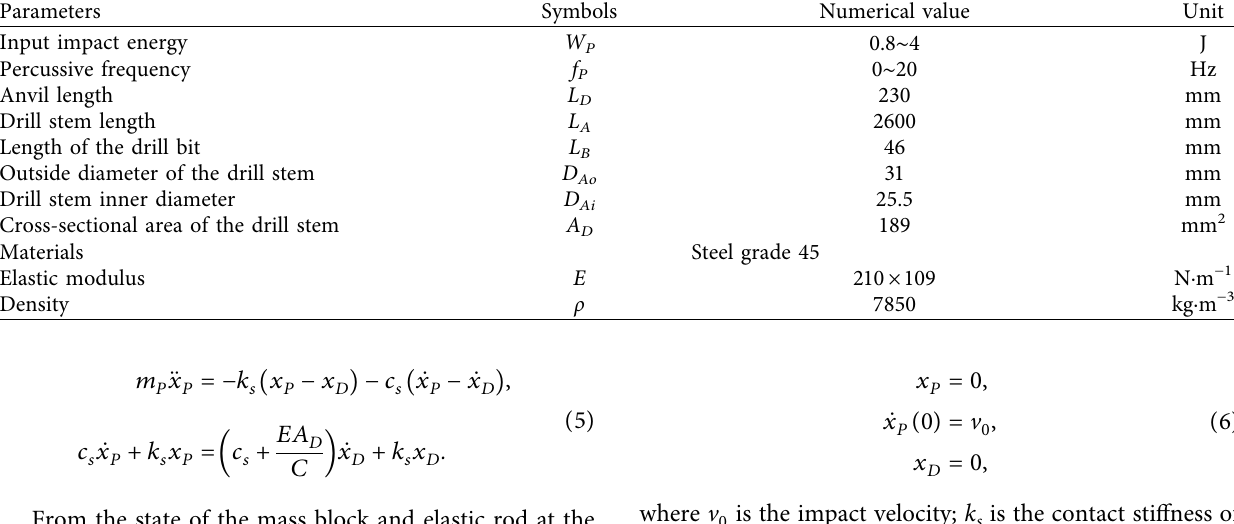
Table 1: Constant parameters used in the transmission analysis of impact stress on drill. Parameters Symbols Numerical